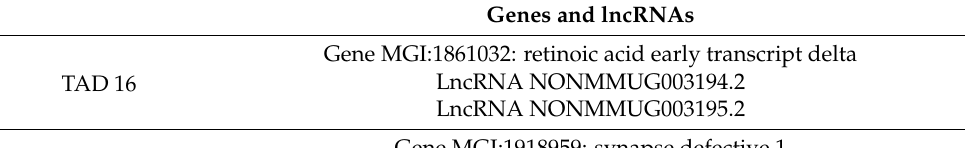
Table 4. The genes and lncRNAs existing in a pair of long-range highly interactive regions. The protein-coding genes in this region share similar functions. In terms of MFO, the functional similarity between MGI:1861032 (retinoic acid early transcript delta) and MGI:106618 (tubulin polyglutamylase complex subunit 1) is 0.579, and the functional similarity between MGI:1861032 and MGI:1918959 (synapse defective 1) is 0.600. Genes and lncRNAs Gene MGI:1861032: retinoic acid early transcript delta LncRNA NONMMUG003194.2 TAD 16 LncRNA